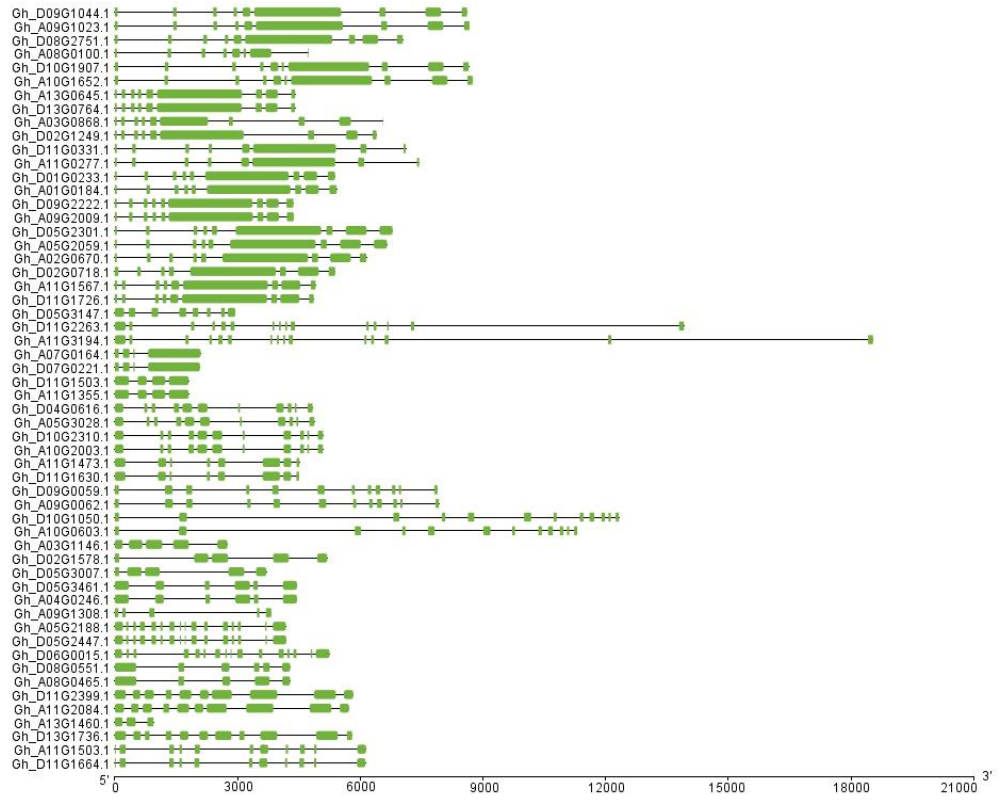
Figure 2. The exon/intron organization of RCC1 genes of G. hirsutum . ( Left ) GhRCC1 family gene names. Green bars = exons, black lines = introns. Each bar section = 3 kb.